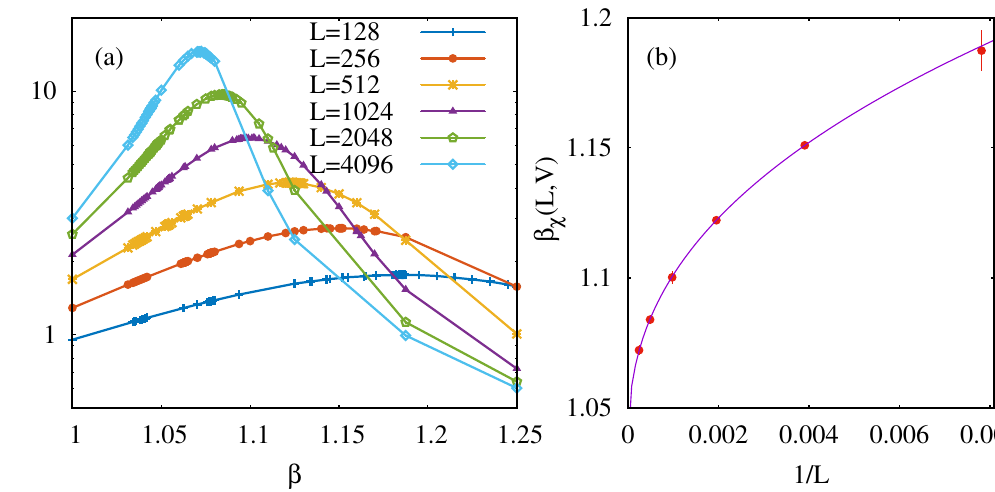
Figure 5: FSS analysis of the magnetic susceptibility in the finite-temperature regime (in all panels, α = 1.50 and V = 5.0). Panel (a): susceptibility curves as a function of β for different system sizes. Solid lines are a guide to the eye. Panel (b): finite- size peak positions β χ ( L ) . The continuous line is a numerical fit to the expected FSS behavior in eq.